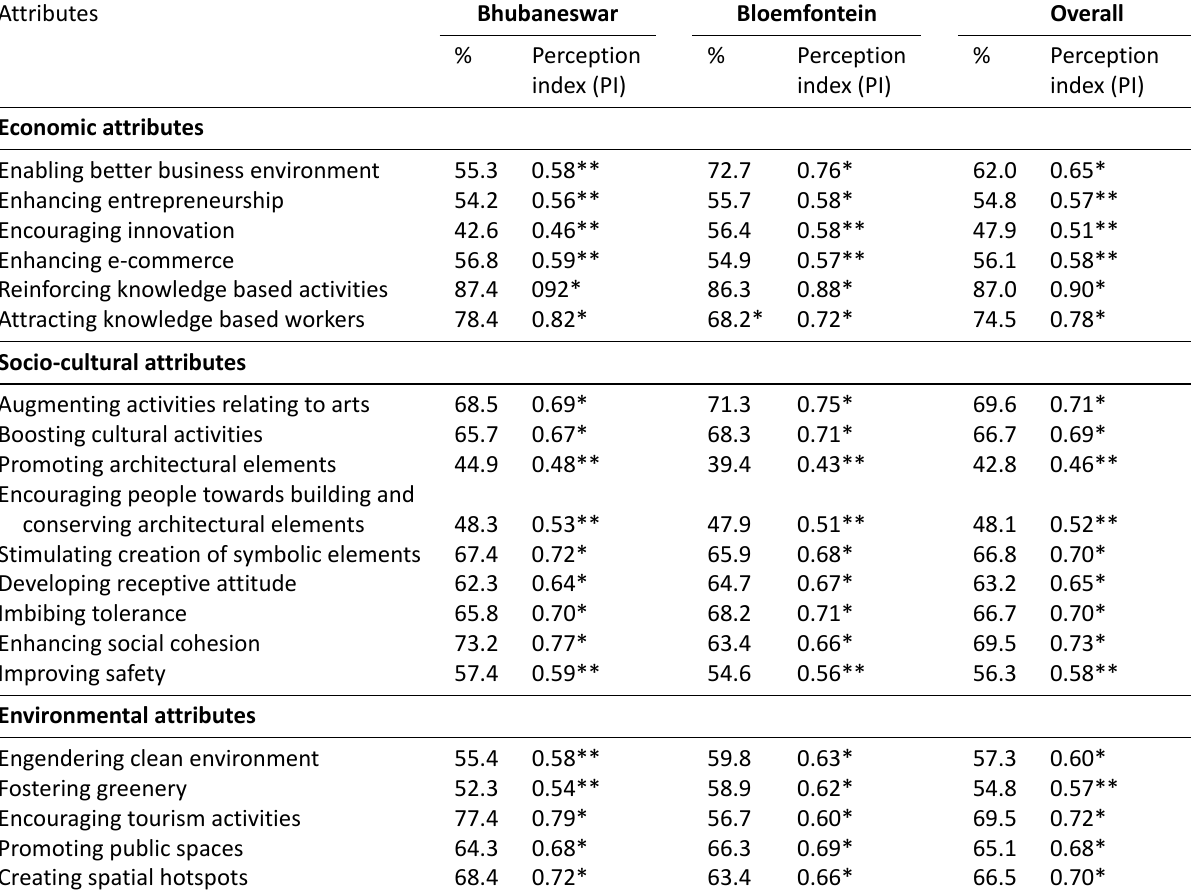
Table 3. Level of influence ICT in developing a creative